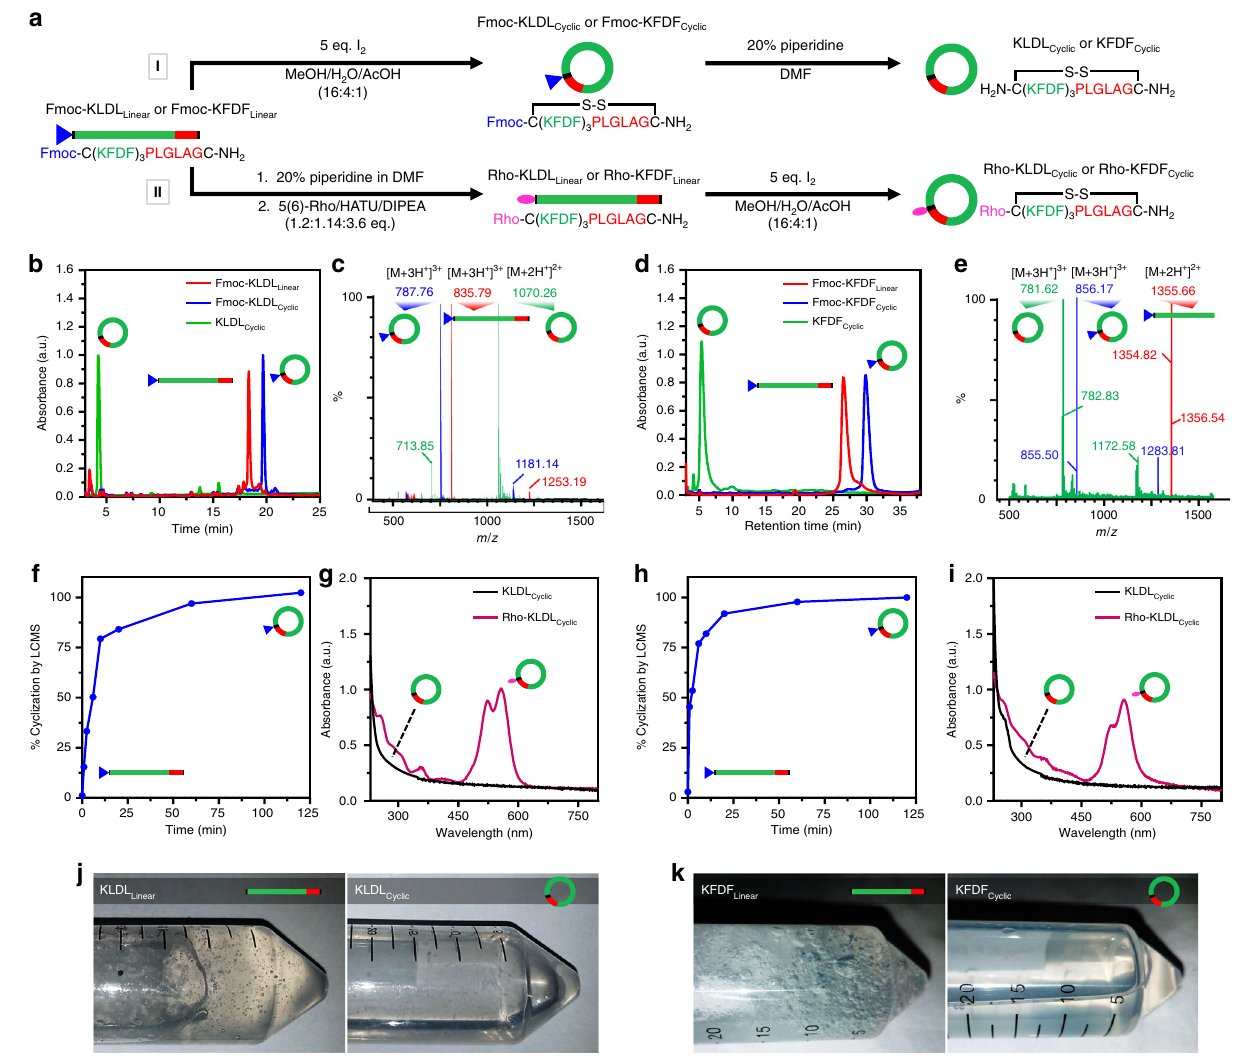
Fig. 4 Facile synthesis of sterically constrained and labeled cyclic progelators. a Synthetic scheme for unlabeled (route I) and labeled (route II) KLDL Cyclic and KFDF Cyclic progelators. All self-assembling peptides (SAPs) were cyclized under dilute conditions (500 µ M) with 5 eq I 2 in a mixture of AcOH/MeOH/ H 2 O to create a soluble progelator. Route I uses N-terminal Fmoc-protected SAPs to improve material separation during chromatographic puri fi cation. Fmoc removal generates the intended unlabeled progelators KLDL Cyclic and KFDF Cyclic . Route II depicts the synthesis of labeled progelators through N- terminal modi fi cation with 5(6)-carboxytetramethyl rhodamine prior to cyclization. b , c High-performance liquid chromatography (HPLC) ( b ) monitored at 214 nm and corresponding electrospray ionization (ESI) spectra ( c ) of Fmoc-KLDL Linear (red), Fmoc-KLDL Cyclic (blue), and KLDL Cyclic (green) (835.79 m/z , 787.76 m/z , and 1070.26 m/z , respectively) verify purity and mass of synthetic modi fi cations to KLDL peptides. d , e HPLC ( d ) monitored at 214 nm and corresponding ESI spectra ( e ) of Fmoc-KFDF Linear (red), Fmoc-KFDF Cyclic (blue), and KFDF Cyclic (green) (781.862 m/z , 856.17 m/z , and 1355.66 m/z , respectively) verify purity and mass of synthetic modi fi cations to KFDF peptides. In both KLDL and KFDF systems, macrocyclization causes a slight decrease in polarity and Fmoc-deprotection increases progelator polarity. f KLDL Linear SAP macrocyclization kinetics monitored by liquid chromatography – mass spectrometry (LCMS) at 214 nm reveal complete cyclization after 120 min. g Absorbance spectra of unlabeled (black) and labeled KLDL progelators (pink, λ max = 565 nm for rhodamine signal). h KFDF Linear SAP macrocyclization kinetics monitored by LCMS at 214 nm reveal complete cyclization after 120 min. i Absorbance spectra of unlabeled (black) and labeled KFDF progelators (pink, λ max = 565 nm for rhodamine signal). j Photographs of KLDL Linear precursor as a hydrogel (left) and the resulting KLDL Cyclic progelator as a soluble solution (right). k Photographs of KLDL Linear precursor as a hydrogel (left) and the resulting KLDL Cyclic progelator as a soluble solution (right)